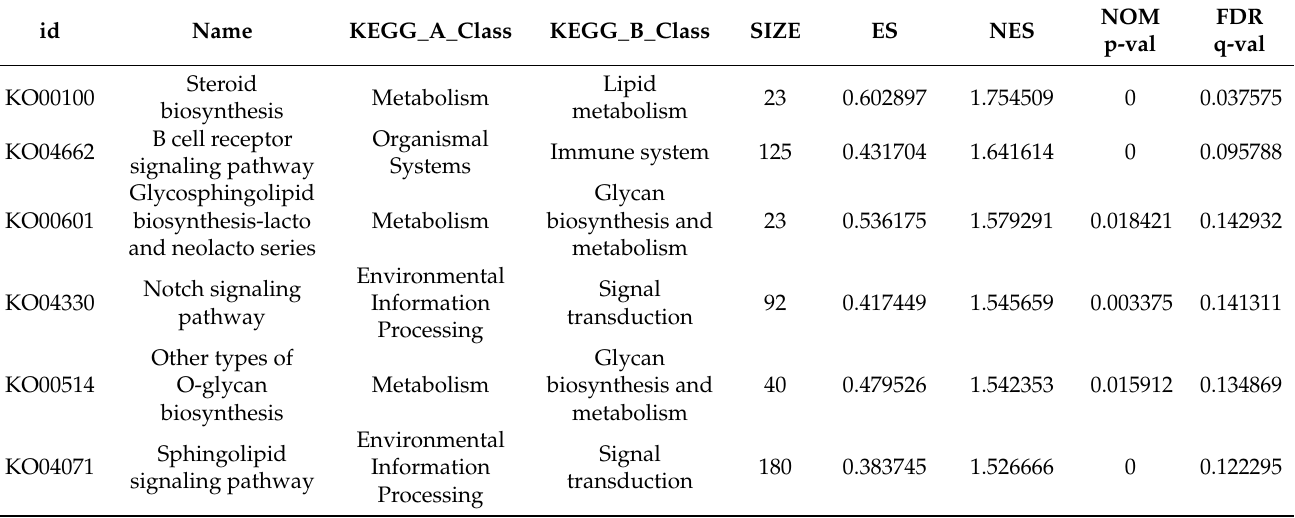
Table 7. Ten KEGG-enriched pathways significantly upregulated in gene set enrichment analy- sis